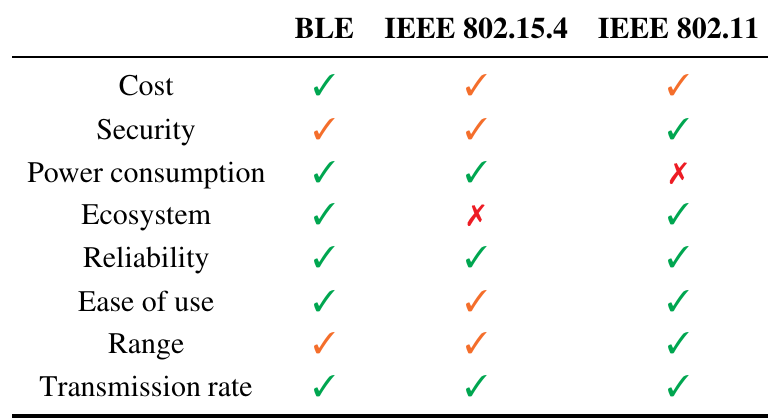
Table 1. Comparison of wireless technologies and their usefulness in smart homes. BLE, Bluetooth Low